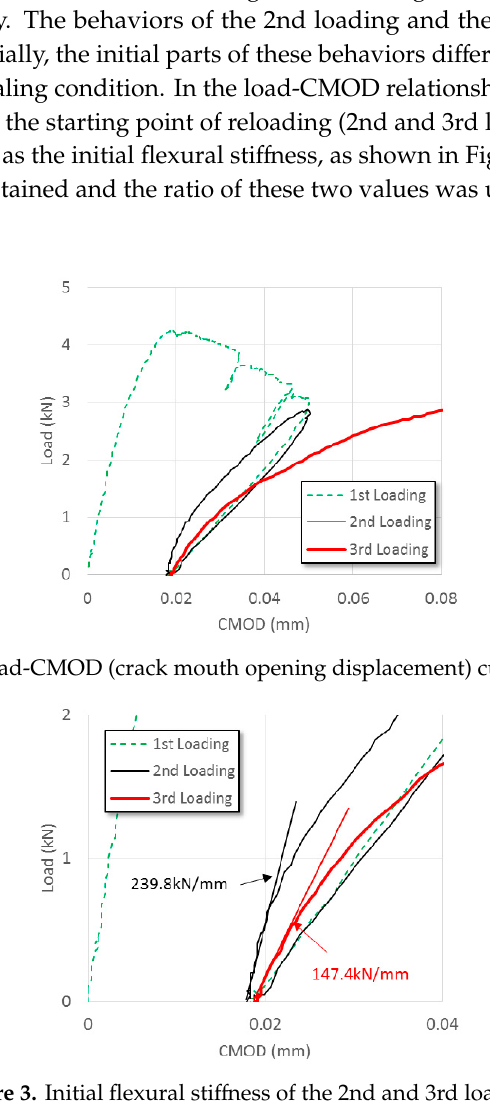
Figure 3. Initial flexural stiffness of the 2nd and 3rd loading.